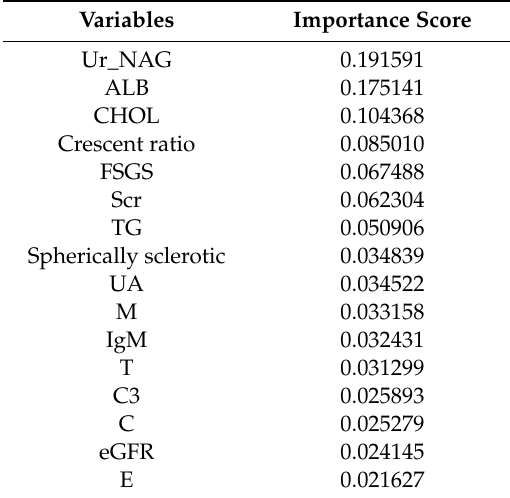
Table 6. The corresponding variable importance score using